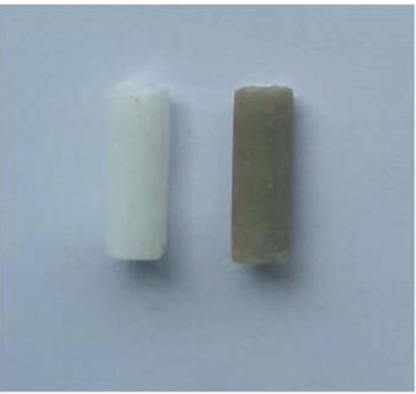
Figure 1: The appearance of the organic monolith before ( left ) and after ( right ) incorporation of